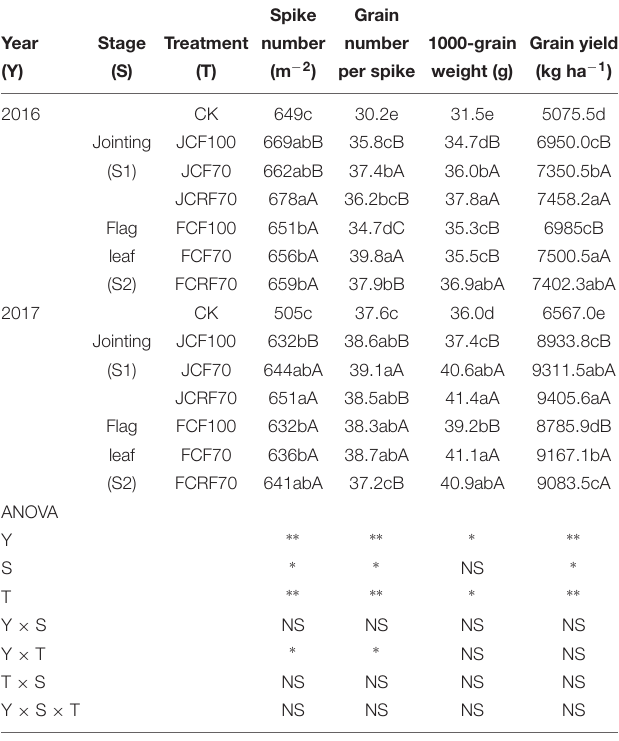
TABLE 6 | Wheat yield and yield components with different N fertilizer management